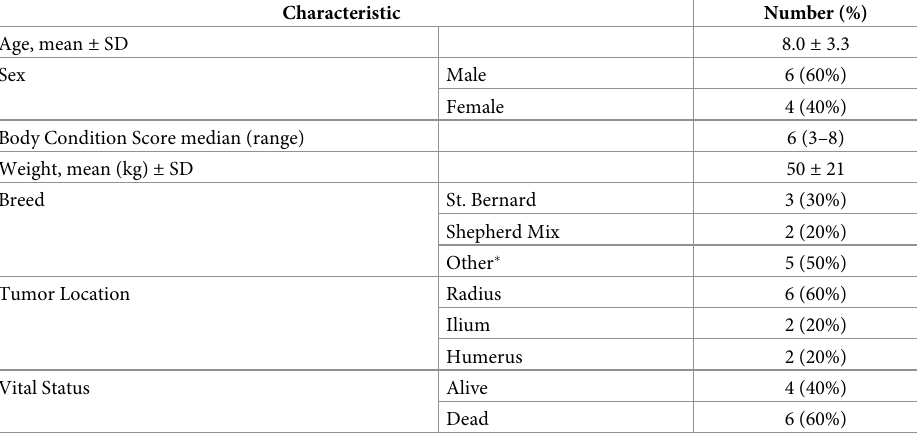
Table 1. Clinical characteristics and vital status of canine patients on clinical